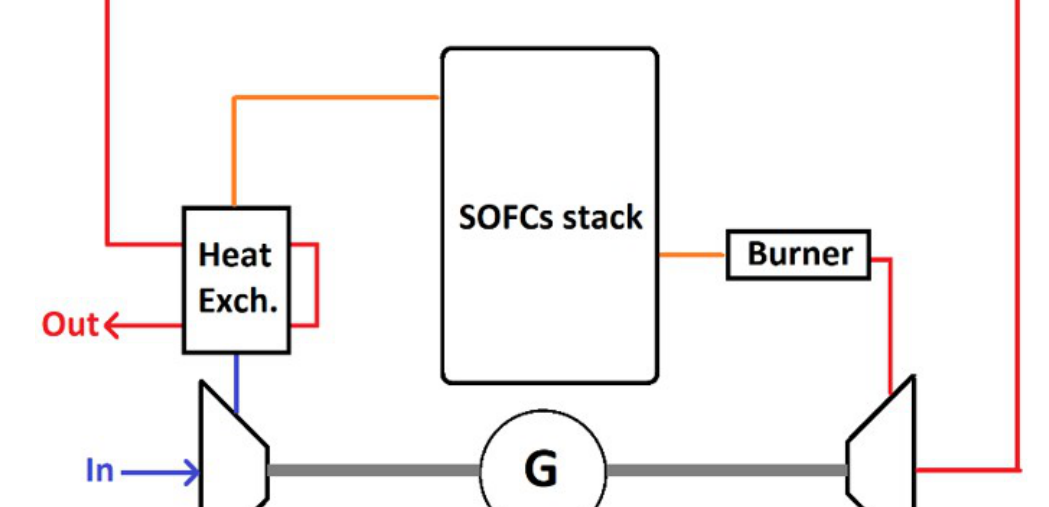
Figure 7. Example of a pressurised air supply system for an solid oxide fuel cell (SOFC) stack.